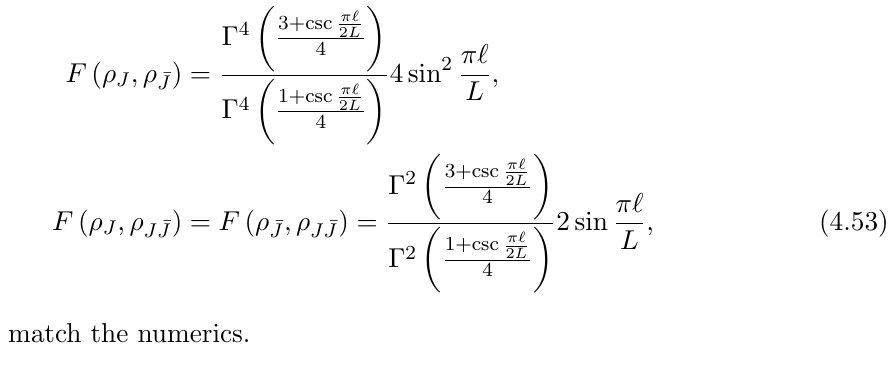
Figure 7 . Fidelity F ( (cid:26); (cid:27) ) as a function of the ratio between the subsystem ‘ and the system size L in the free compact boson. Solid lines are the CFT predictions for short distance, eqs. (4.48) to (4.53). The symbols joined by dashed lines represent numerical data, with di(cid:11)erent symbols corresponding to di(cid:11)erent L . Di(cid:11)erent colours correspond to di(cid:11)erent pairs of states (cid:26) and (cid:27) . as well